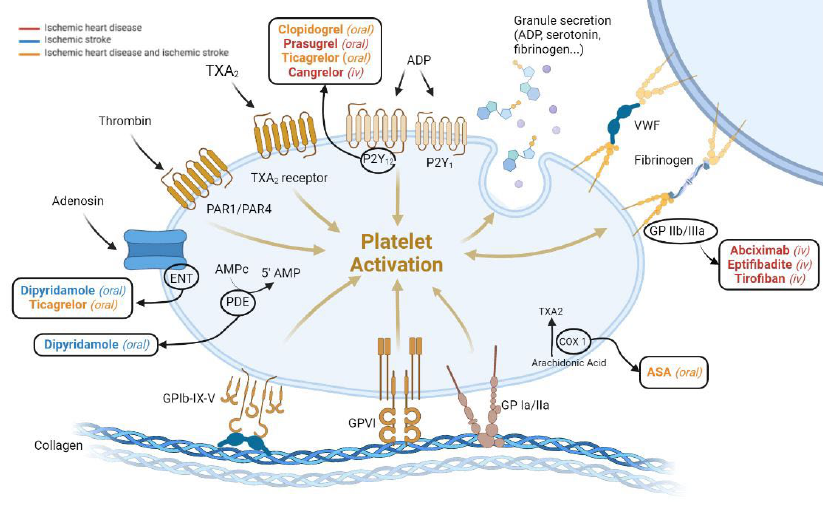
Figure 1. Antiplatelet drugs currently used to treat ischemic heart disease and ischemic stroke. ENT: equilibrative nucleoside transporter; ASA: acetylsalicylic acid; TXA2: thromboxane A2; VWF: Von Willebrand Factor; PDR: phosphodiesterase; COX: cyclooxygenase. Figure created with BioRender.com.